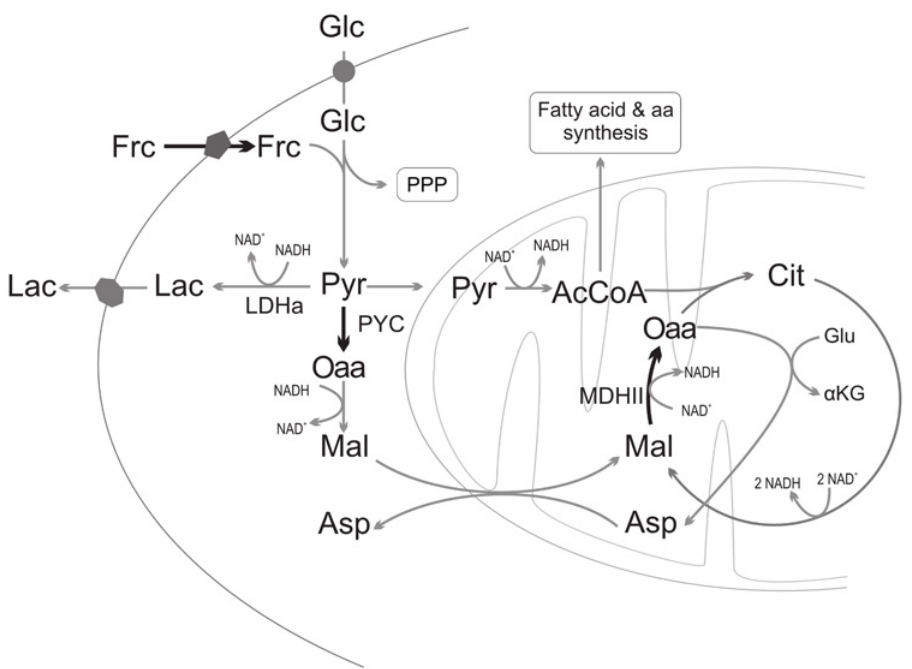
Fig 2. Impact of each of the modifications over CHO cells ’ metabolism. Reactions catalyzed by overexpressed enzymes are represented by bold lines. Glc: Glucose, Frc: Fructose, Cit: Citrate, AcCoA: Acetyl CoA, Mal: Malate, Oaa: Oxaloacetate, Asp: Aspartate, Pyr: Pyruvate, Lac: Lactate, α KG: α ketoglutarate, LDHa: Lactate Dehydrogenase a, PPP: Pentose Phosphate Pathway.